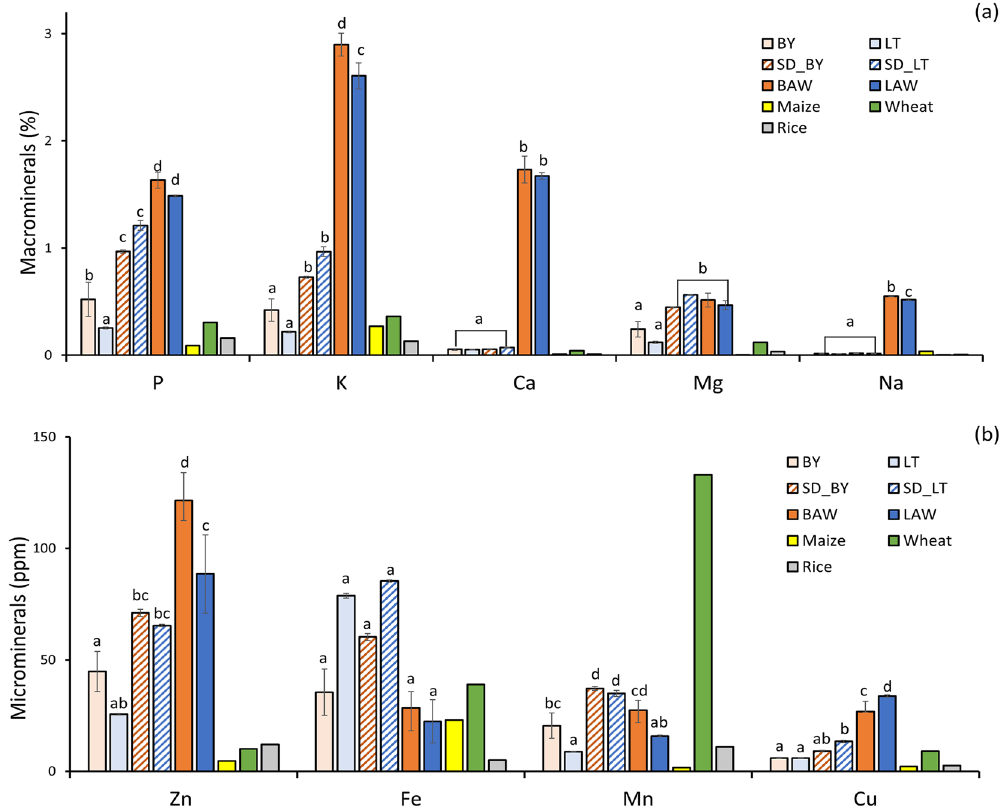
Figure 5. Mineral profile of acid whey millet powders and millet flours ( a ) macronutrients ( b ) micronutrients. The data for maize, wheat, and rice was obtained from Chandra et al. 38 . Legend: Mineral content in the powder samples .BY: plain Barnyard millet flour; LT: plain Little millet flour; SD_BY: spray dried Barnyard millet soluble fraction; SD_LT: spray dried Little millet soluble fraction; BAW: 25% w/v Barnyard millet + acid whey; LAW: 25% w/v Little millet + acid whey.